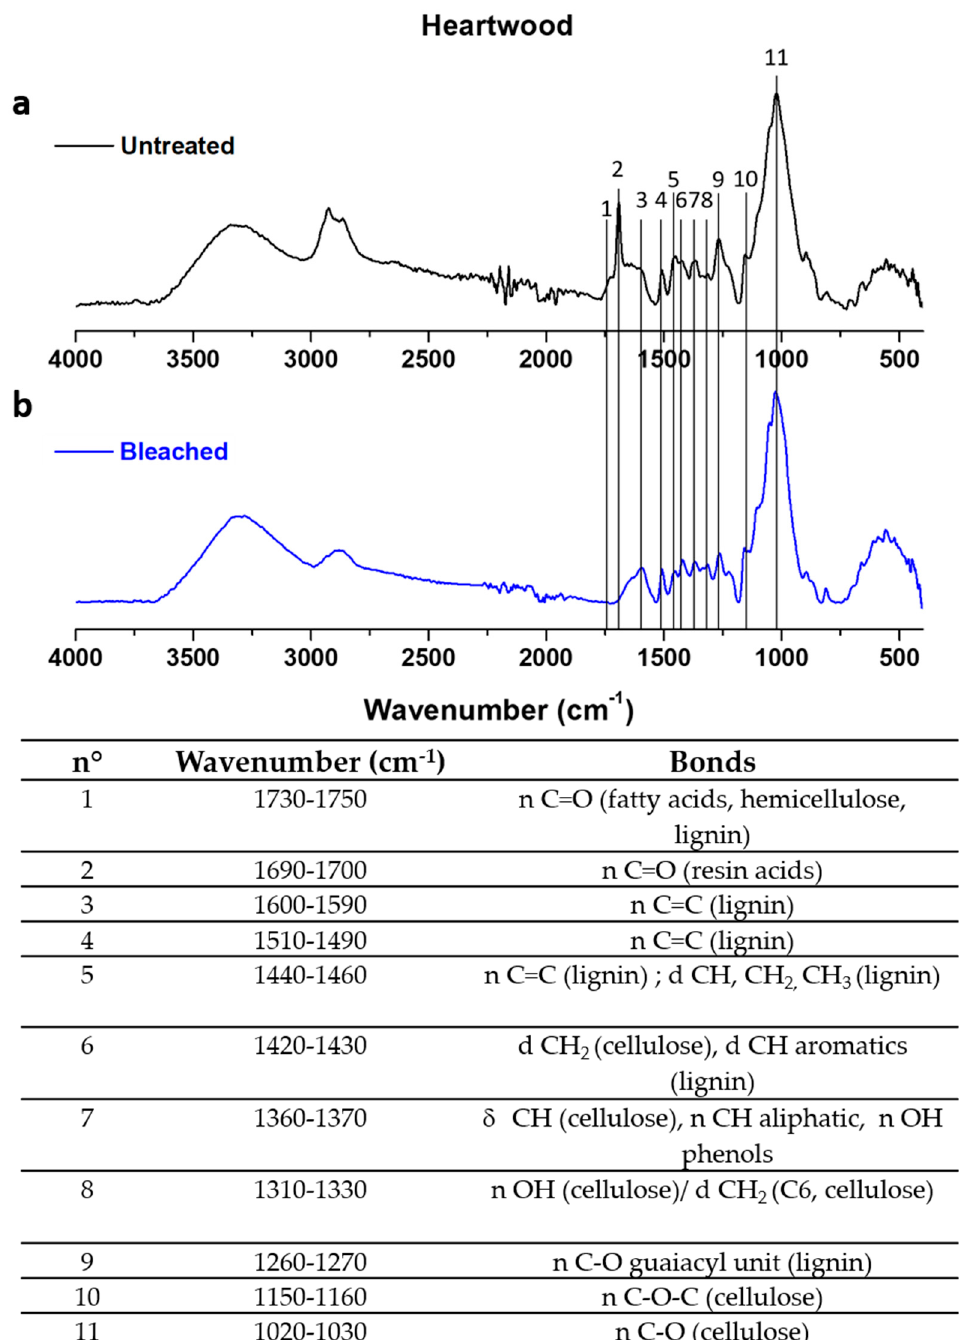
Figure 1. ATR spectra of untreated ( a ) and H 2 O 2 treated heartwood ( b ) powders and wavenumbers attribution.